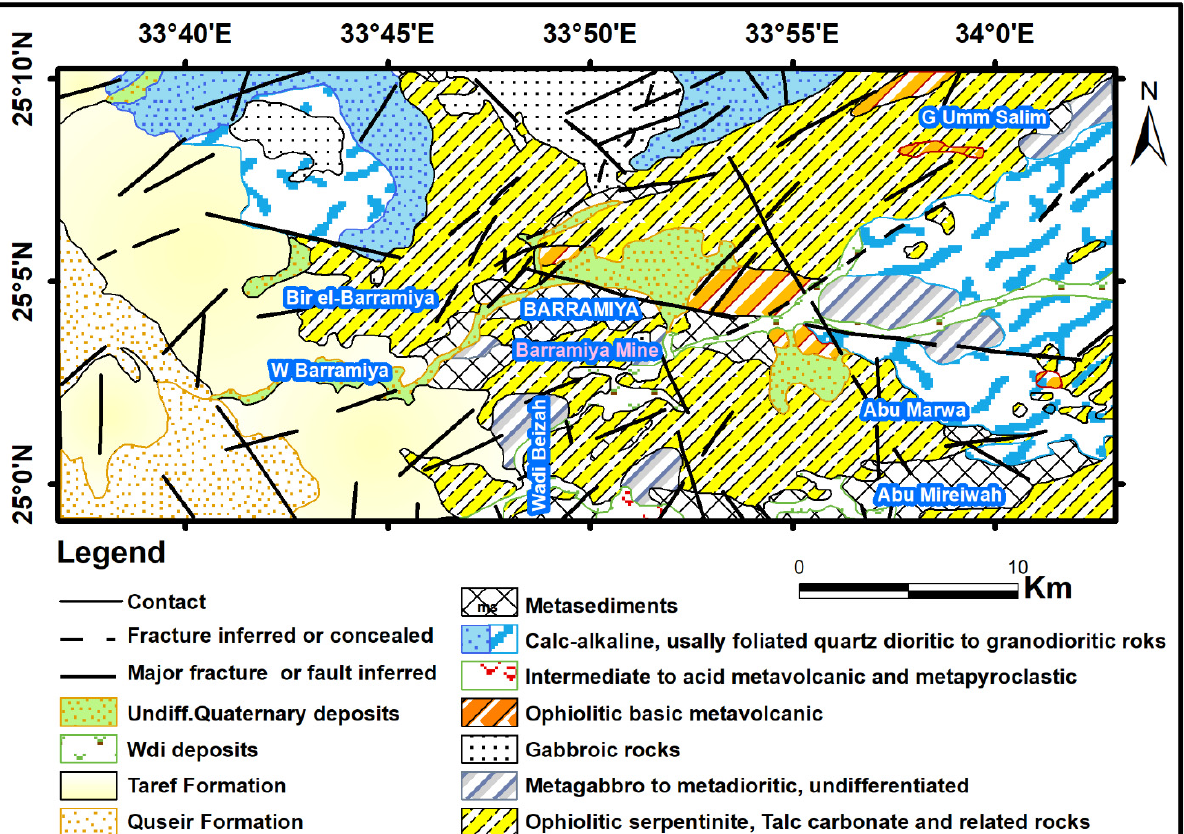
Figure 1. Geological map of El-Barramiya-Abo Marwa area, Eastern Desert (modified after [13]).